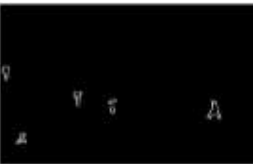
Figure 9. Edge detection with canny edge detector.